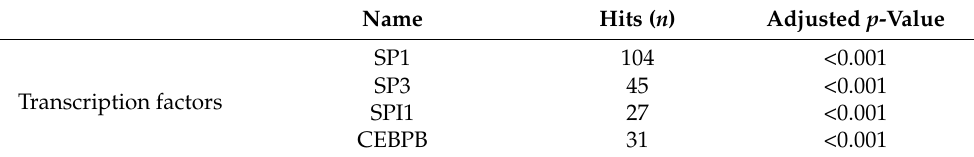
Table 2. Significant overrepresentation in VAT of validated targets of transcription factors (TF), TF complexes or families in HFoleic vs. Reference group